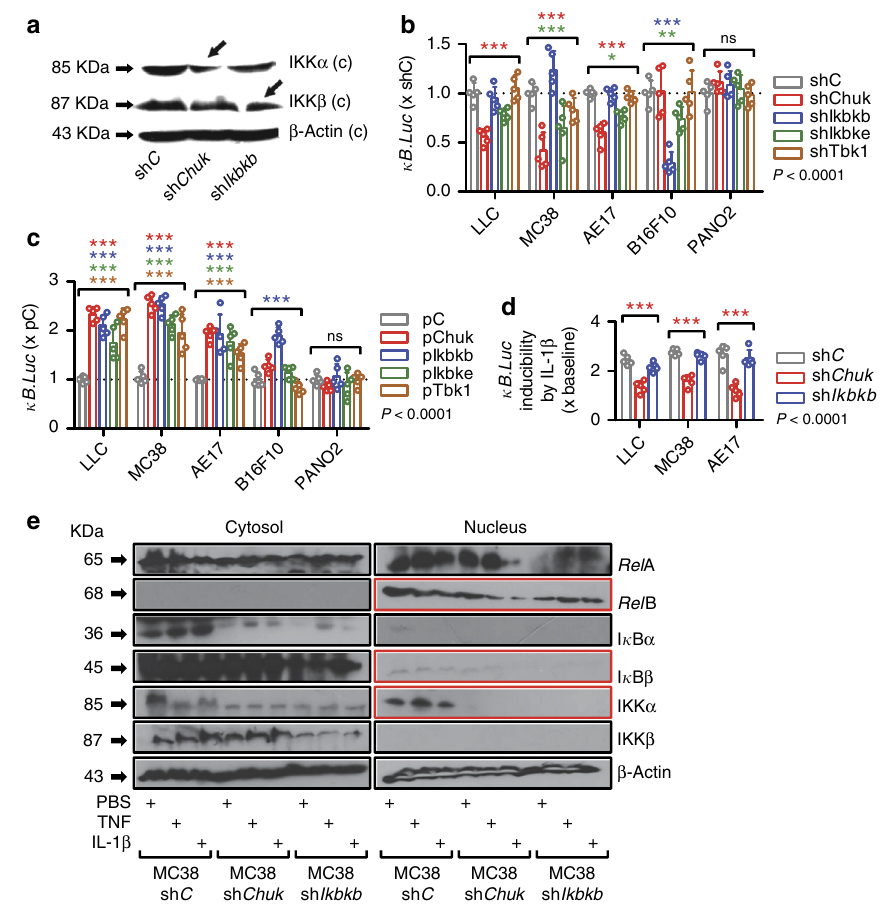
Fig. 5 IL-1 β -induced NF- κ B signaling of KRAS -mutant cells is IKK α dependent. Five different C57BL/6 mouse tumor cell lines with (LLC, MC38, AE17) or without (B16F10, PANO2) Kras mutations were stably transfected with p NGL NF- κΒ reporter and any of the following: control shRNA (sh C ) or shRNA targeting IKK α (sh Chuk ), ΙΚΚβ (sh Ikbkb ), ΙΚΚε (sh Ikbke ), or TBK1 (sh Tbk1 ) transcripts; control plasmid (p C ); or overexpression vectors encodong IKK α (p Chuk ), ΙΚΚβ (p Ikbkb ), ΙΚΚε (p Ikbke ), or TBK1 (p Tbk1 ) transcripts. a Immunoblot of cytoplasmic protein extracts from LLC cells stably expressing sh C , sh Chuk , or sh Ikbkb for IKK α and IKK β relative to β -actin (representative of n = 3 independent experiments). b Bioluminescent quanti fi cation of NF-